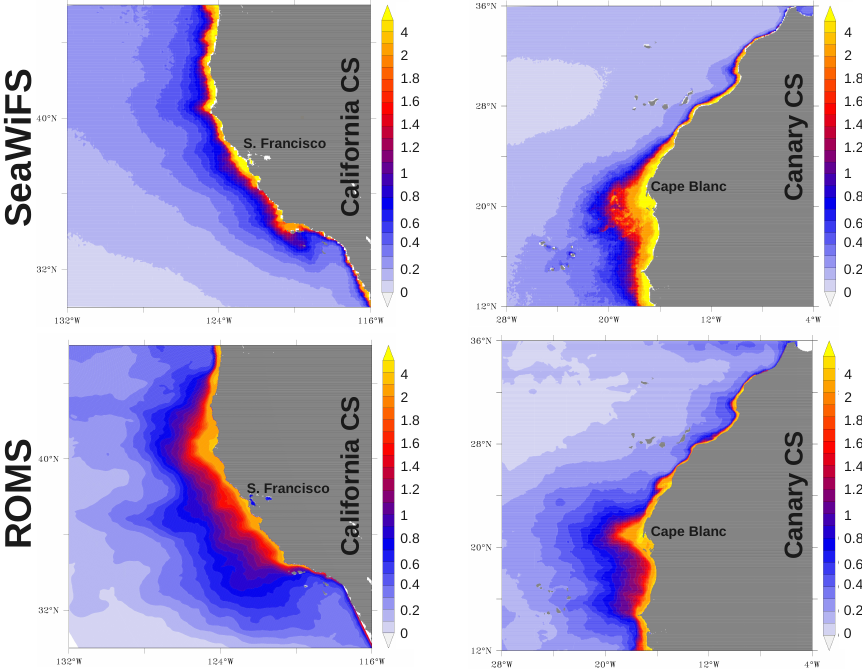
Fig. 1. Annual average of surface chlorophyll- a concentrations (mgm − 3 ) from SeaWiFS (top) and ROMS model (bottom) in the California CS (left) and the Canary CS (right). The SeaWiFS climatology is computed over the period from 1997 to 2007.